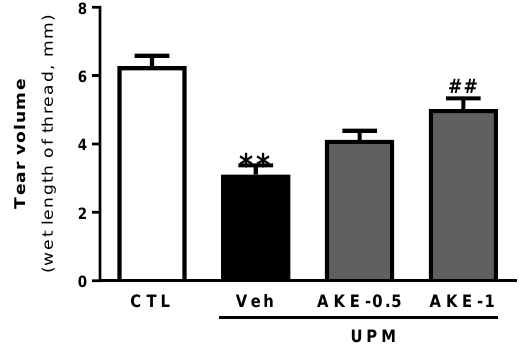
Figure 1. Effects of AKE on aqueous tear secretion in the UPM exposure-induced KCS model. The tear volume is expressed as the length of thread (mm) that turned red from the tear fluid. Control group: CTL; vehicle group: Veh; 0.5 mg/mL AKE-treated group: AKE-0.5; and 1 mg/mL AKE-treated group: AKE-1. Data shown are mean ± standard error of the mean (n ≥ 8). ** p < 0.01 vs. CTL, ## p < 0.01 vs. Veh.